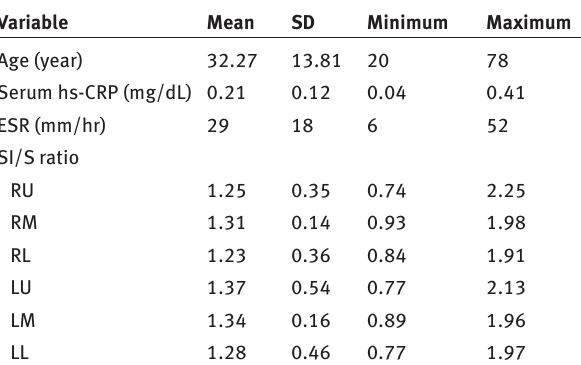
Table 1: Demographic characteristics of enrolled patients (N = 29; Female = 6, Male = 23)